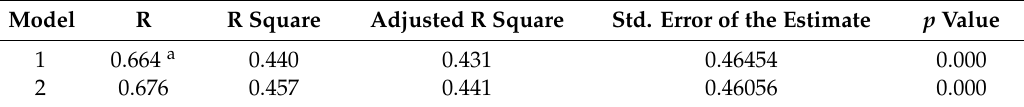
Table 5. Moderated regression